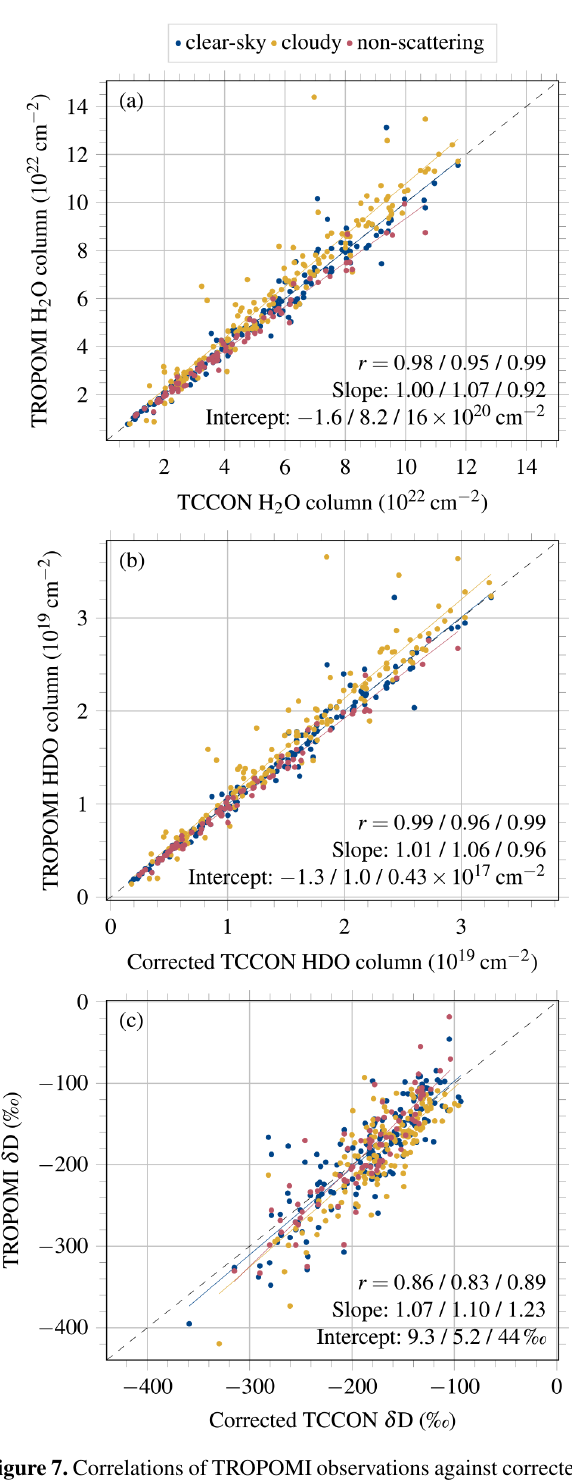
Figure 7. Correlations of TROPOMI observations against corrected TCCON measurements of (a) H 2 O columns, (b) HDO columns and (c) a posteriori δ D for clear-sky scenes (blue), cloudy scenes (yellow) and the non-scattering retrieval (red) at Karlsruhe. The coloured lines represent linear fits and the dashed line denotes the one-to-one line.